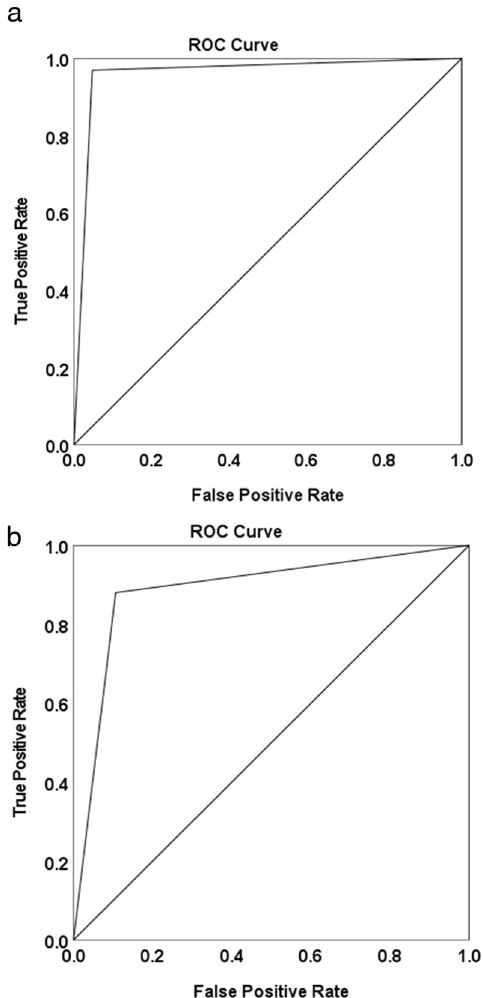
Fig. 3 Receiver Operating Characteristic (ROC) for selected teeth and Full dentition assessments. a ROC for Selected study teeth assessment (LC Rinse vs ICDAS). Area under the ROC curve: 96.11%. b ROC for Full dentition assessment (LC Rinse vs ICDAS). Area under the ROC curve: